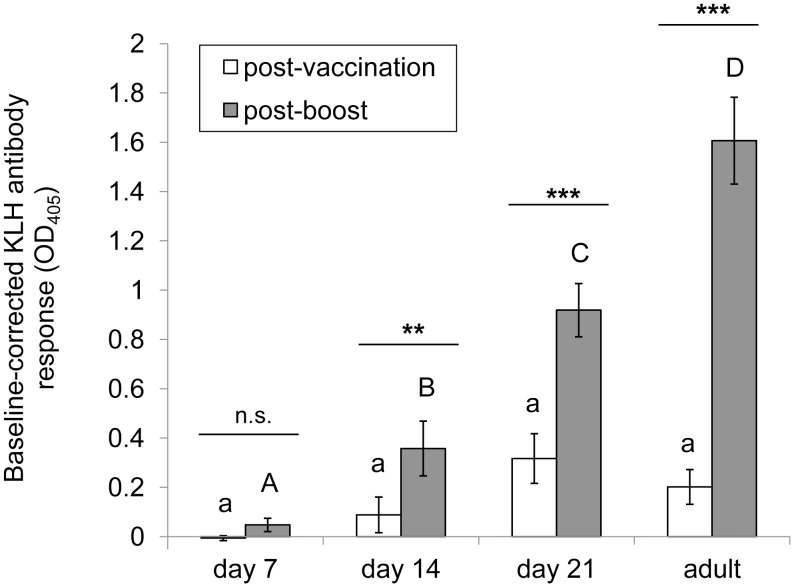
KLH-specific antibody response in vaccinated zebra finch nestlings and adults.Data are means ± s.e.m. (n = 13 for 7d and 14d groups, n = 14 for 21d and adult groups). Post-priming vaccination (unfilled bars) and post-boost (filled bars) absorbance values were corrected for absorbance values of baseline blood samples on KLH-specific ELISA. Post-vaccination values among age groups that share the same lowercase letter and post-boost values among age groups that share the same uppercase letter are not significantly different as determined by Tukey’s post hoc tests. Significant differences between post-vaccination and post-boost values within an age group (as determined by Tukey’s post hoc tests) are denoted by asterisks.